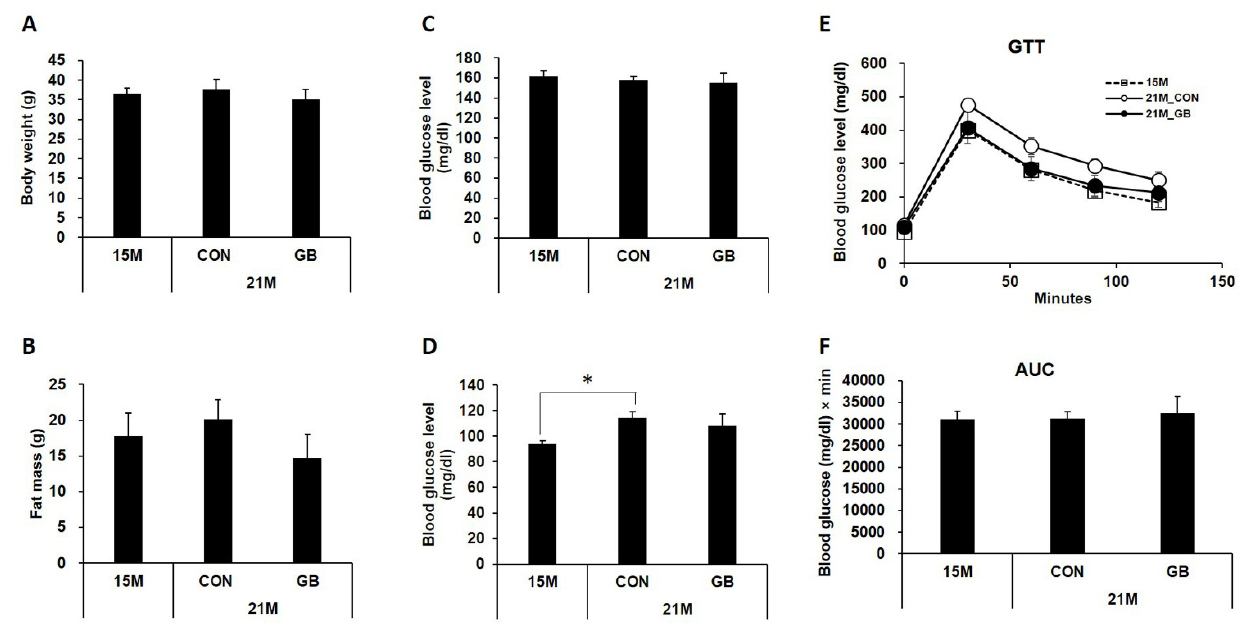
Figure 1. Ginseng berry (GB) extract supplementation does not change the body weight or blood glucose in aged mice. Fifteen-month-old mice were fed a regular diet (CON) or a regular diet supplemented with 0.05% GB extract for 6 months. At 21 months of age, ( A ) body weights were measured; ( B ) whole body fat mass was measured by a 1 H minispec system (LF-90II, Bruker Optics, Germany); and ( C ) non-fasting and ( D ) fasting blood glucose levels were measured; ( E ) glucose tolerance tests were performed as well and ( F ) the area under the curve (AUC) was calculated. Values are means ± SE, n = 8 group −1